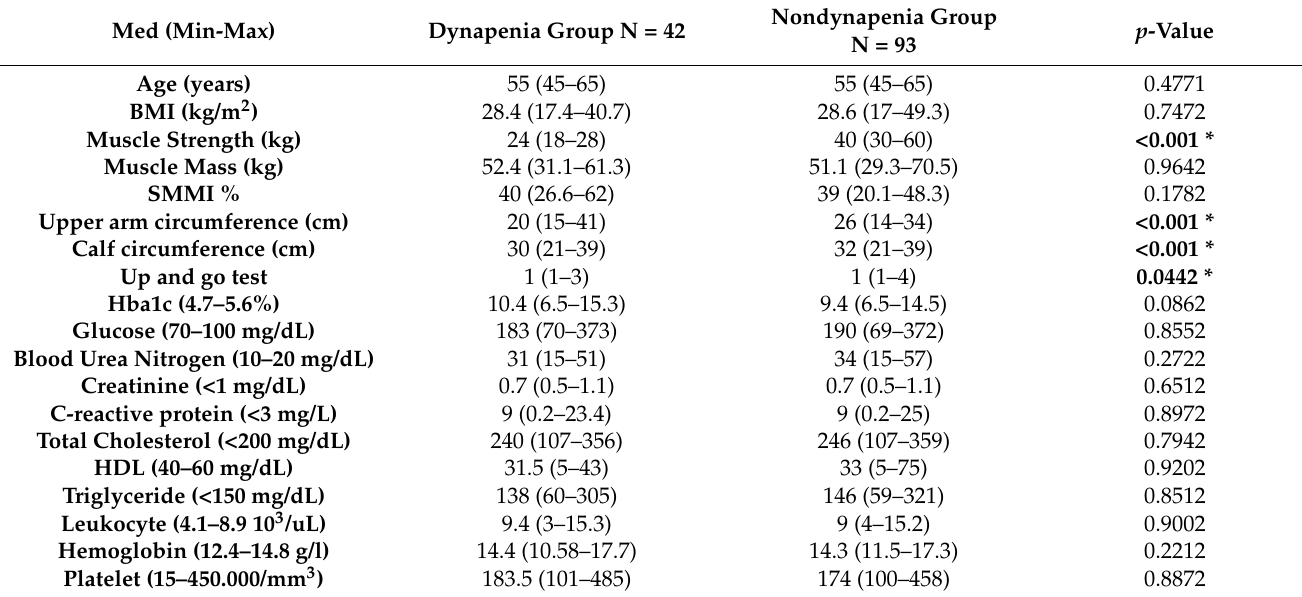
Table 5. Review of all parameters according to dynapenia